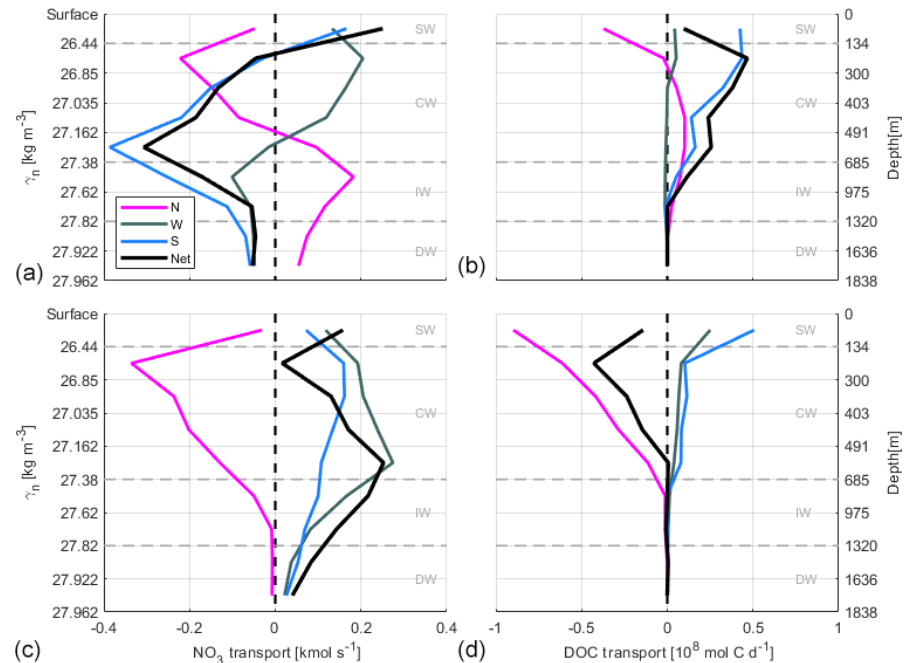
Figure 17. Accumulated NO 3 transports (kmols − 1 ) and accumulated DOC transports (10 8 molCd − 1 ) at transects in the north (N, magenta line), west (W, dark grey line) and south (S, blue line) during fall (a, b) and spring (c, d) . See Table 2 for the γ n values bounding every water layer. Negative–positive values indicate inward–outward transports as in Fig. 12. The net transport in the whole box is shown by the black